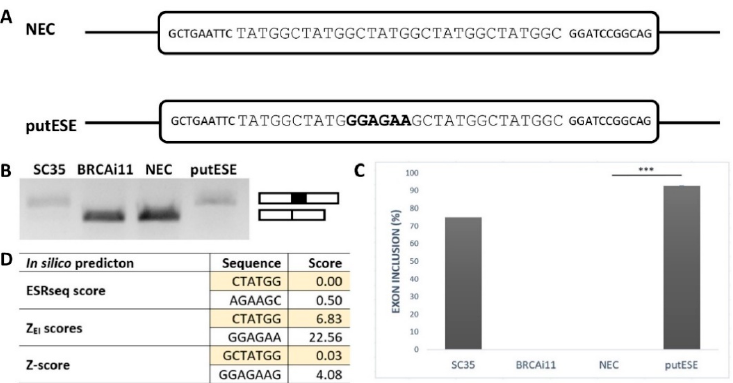
Figure 1. GGAGAA motif acts as a splicing enhancer. ( A ) Schematic representation of no